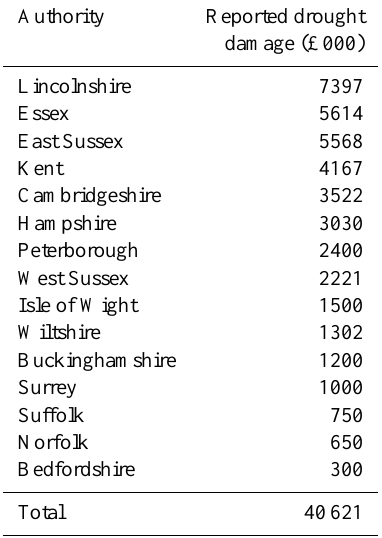
Table 1. Drought damage to roads in 2003 (data sourced from Wilway et al.,